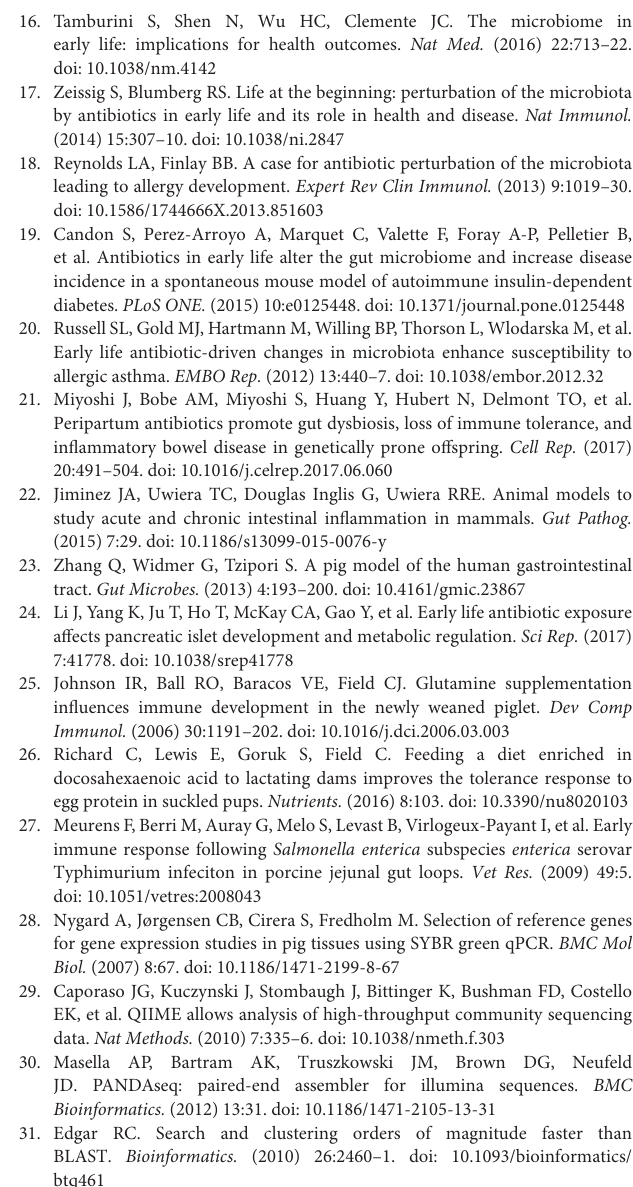
Supplementary Table 4 | Relative abundance of predominant fecal genera on PND 3 of AB and PL piglets 1 . 1 Data presented as mean ± pooled SEM. Data was analyzed using a non-parametric Kruskall Wallis test. AB n = 20, PL n = 21. AB, antibiotic; PL, placebo; PND, post-natal day; SEM, pooled standard error of the mean; n/d, not detected. not